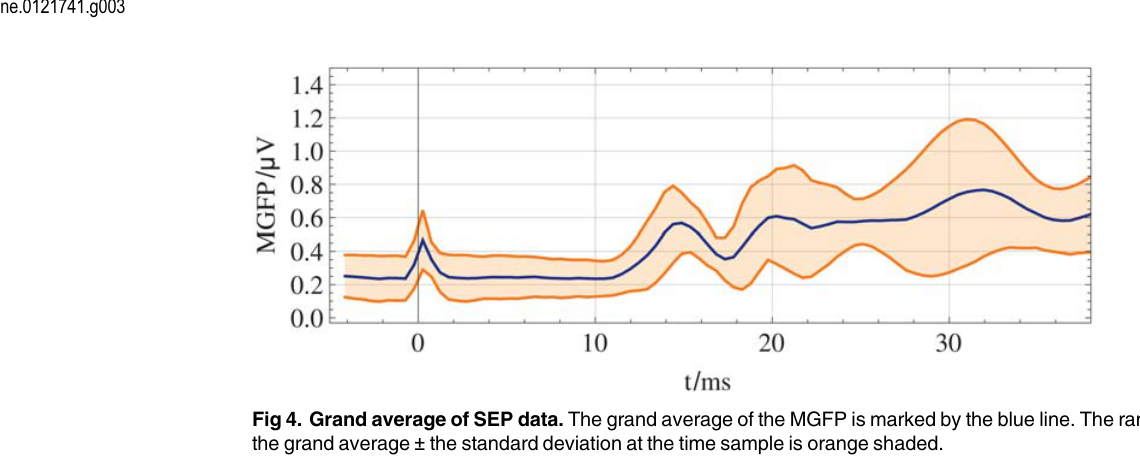
Fig 3. Averaged SEP data for one volunteer. (a) The mean global field power (MGFP), local maxima in activity at 13.3, 19.2 and 29.4 ms after stimulus; (b) The potential distribution on the scalp, view direction is from the top left (L: left; R: right; F: frontal; O: occipital).